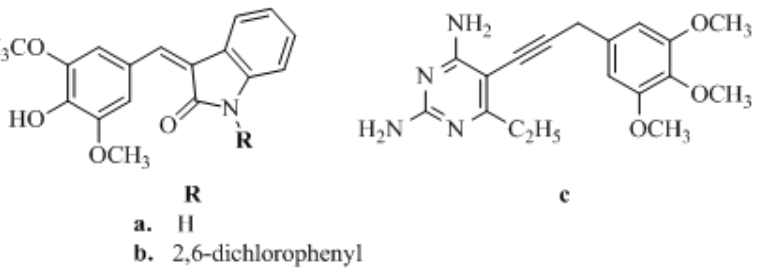
Figure 2. Structures ( a ) R=H ( b ) R=2,6-dichlorophenyl and ( c ) of selected TMP analogs directed at new targets.